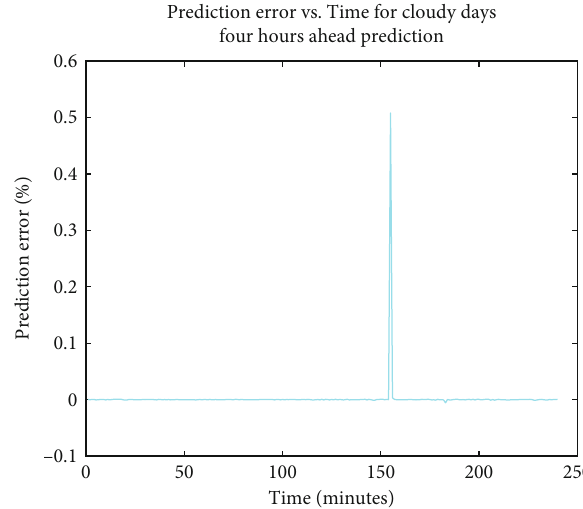
Figure 32: Prediction error vs. time for cloudy day four-hour- ahead prediction.